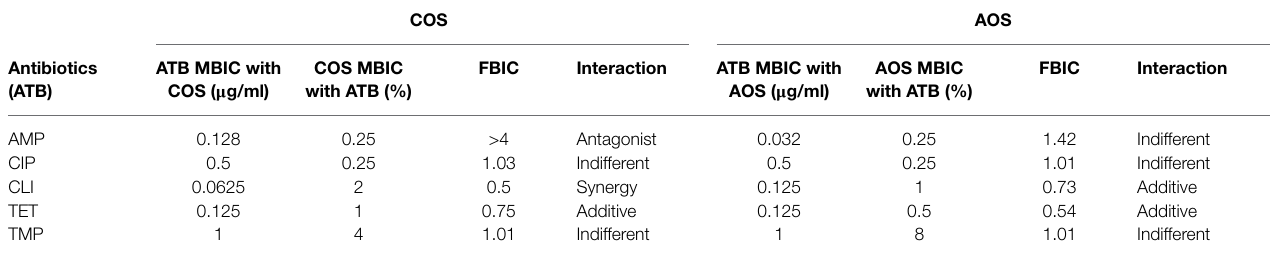
TABLE 2 | MBIC values, FBIC index and the nature of interaction between AOS and COS with AMP, CIP, CLI, TET, and TMP against S. aureus wood 46. COS AOS Antibiotics